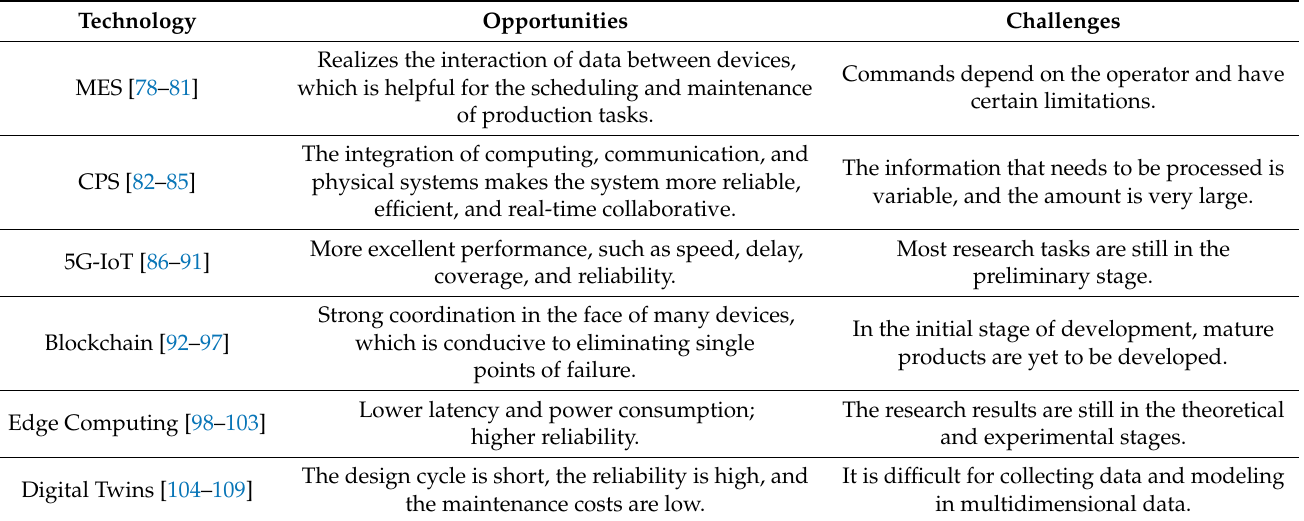
Table 1. Opportunities and challenges of key technologies in intelligent management control and integration